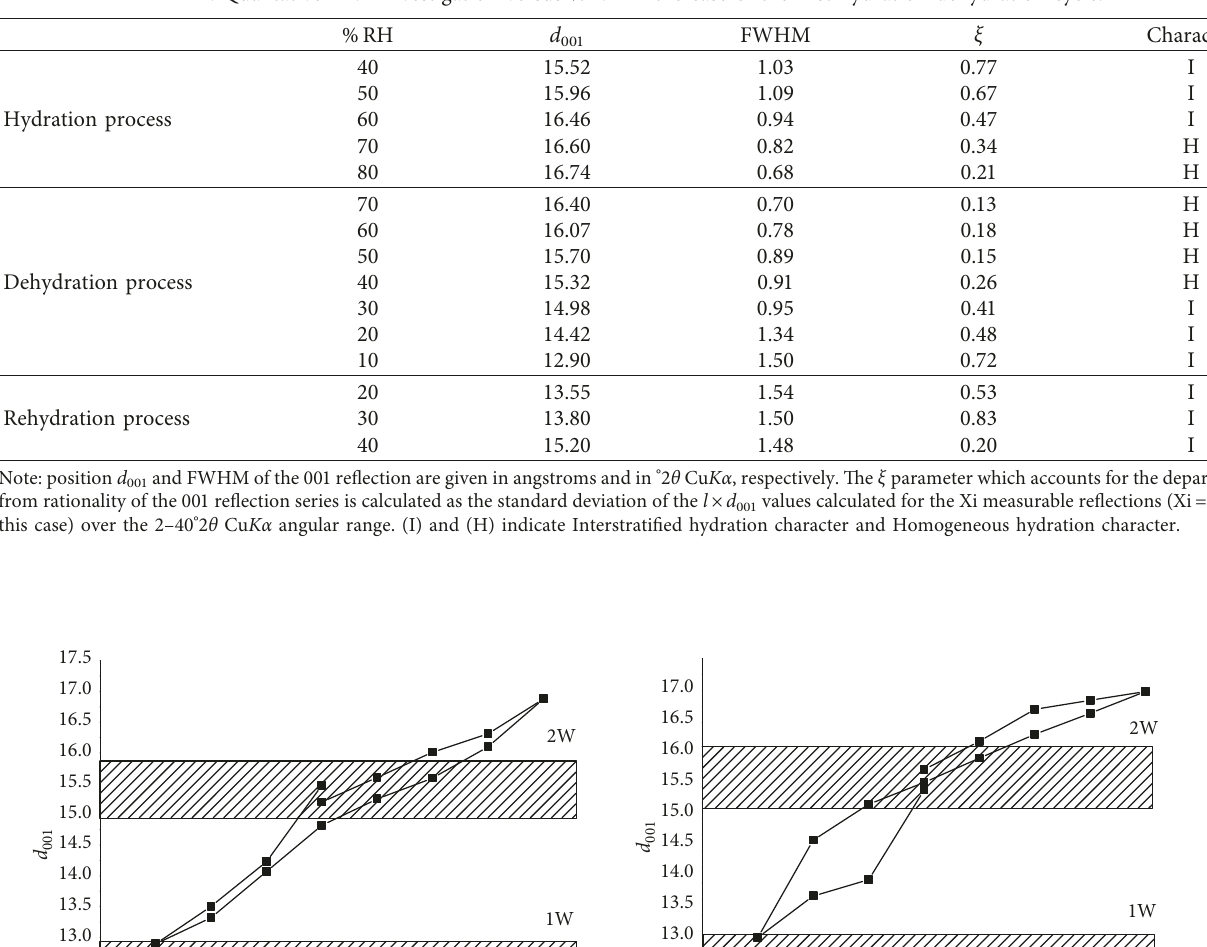
Table 1: Qualitative XRD investigation versus %RH in the case of the first hydration-dehydration cycle.